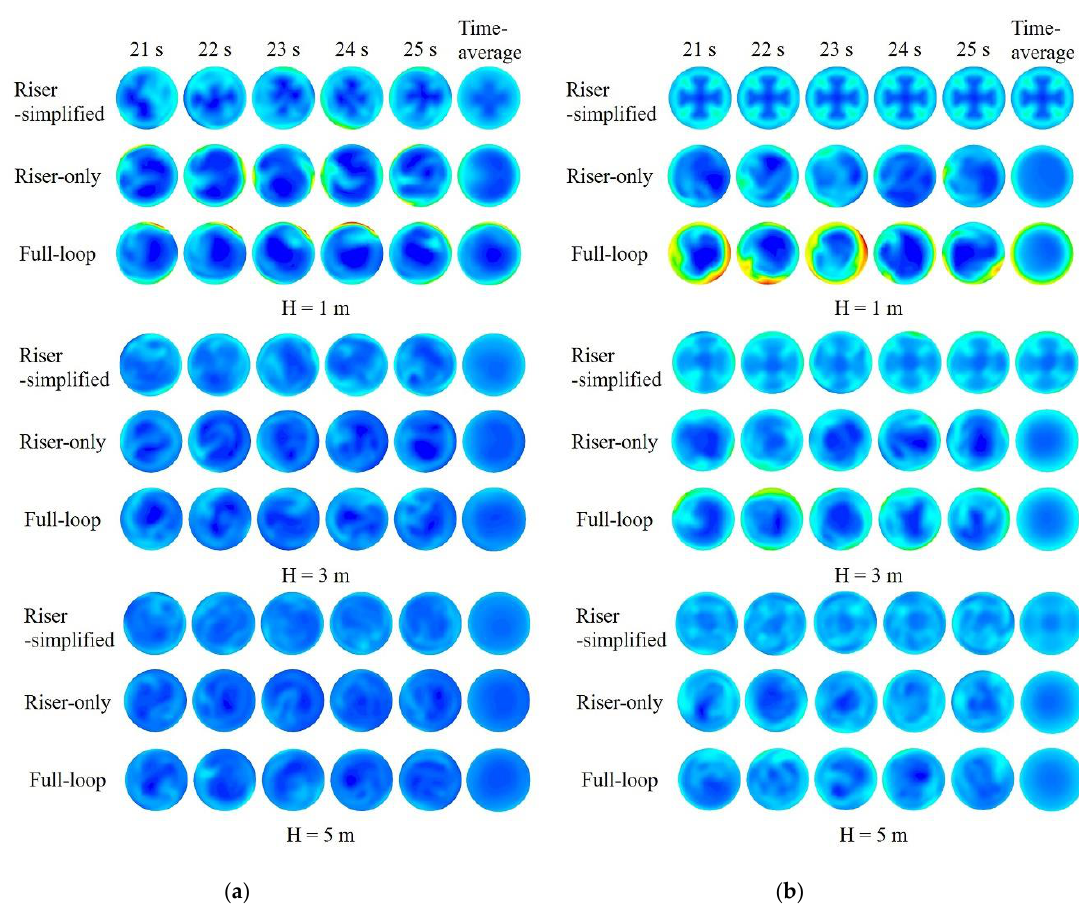
Figure 10. Comparison of transient solids holdup in the riser between different simulations. ( a ) Ug = 7 m s − 1 , Gs = 50 kg m − 2 s − 1 ; ( b ) Ug = 7 m s − 1 , Gs = 300 kg m − 2 s − 1 .